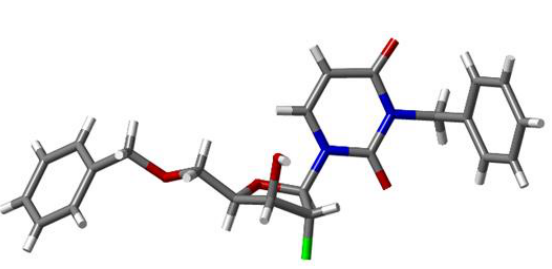
Figure 1. X-ray crystal structure of molecule 12 .